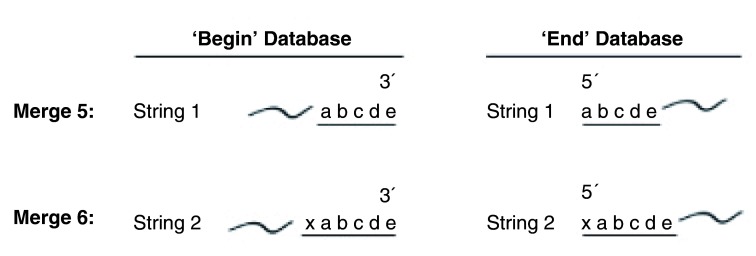
Pictoral depiction of ‘Begin’ and ‘End’ database.The contents of the ‘Begin’ and ‘End’ databases are represented along with the shared amino acid residues at the 3’ and 5’ ends, respectively. The ‘merge5’ command identified the String1 pair in the ‘Begin’ and ‘End’ databases due to the shared sequence ‘abcde’. The ‘merge5’ command failed to identify the String2 pair since six residues are shared. The ‘merge6’ command, however, will recognize String2 in the ‘Begin’ and ‘End’ databases, but would fail to recognize pairs that shared seven or more residues at the 3’ and 5’ ‘End’.